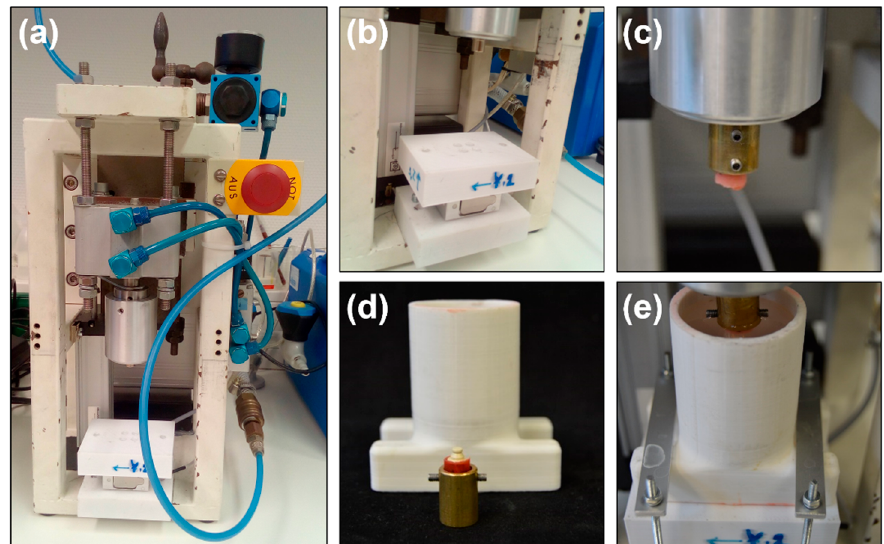
Figure 2. Experimental device for cyclic dislodgement testing. ( a ) Overview image of a Beisser machine; ( b ) working platform; ( c ) a metal holder with a specimen of PVS attachment; ( d ) a specimen of PEEK post-core restoration; ( e ) fixation of a specimen during the testing.